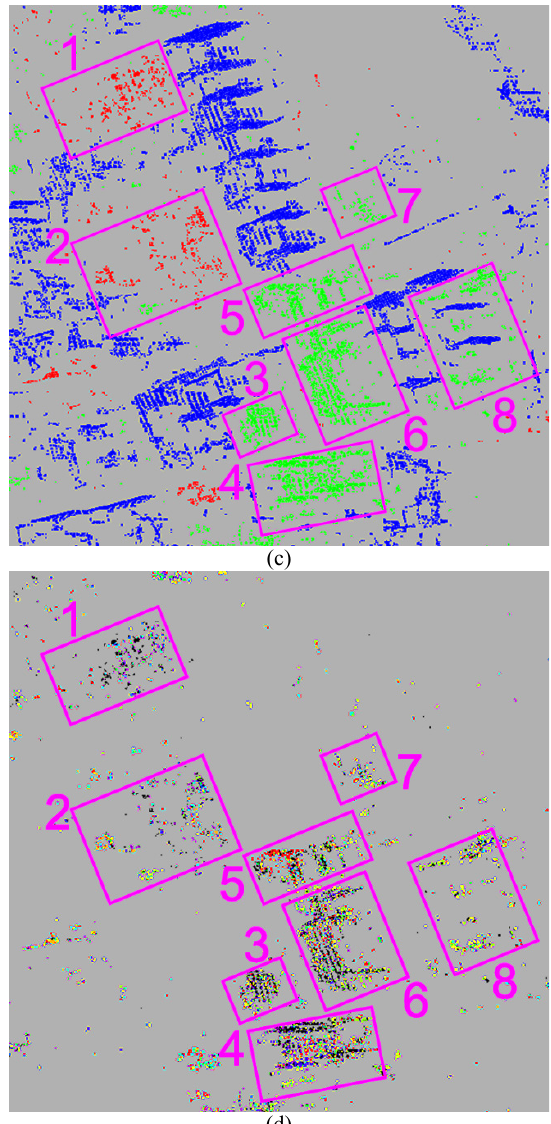
Figure 6. Construction monitoring of business district in patch 2 (Figure 3). Areas 1 to 8 are used for in-depth analysis. GE images were acquired on (a) September 12, 2010 and (b) September 5, 2014. (c) and (d): spatiotemporal change detection result in patch 2 (Figure